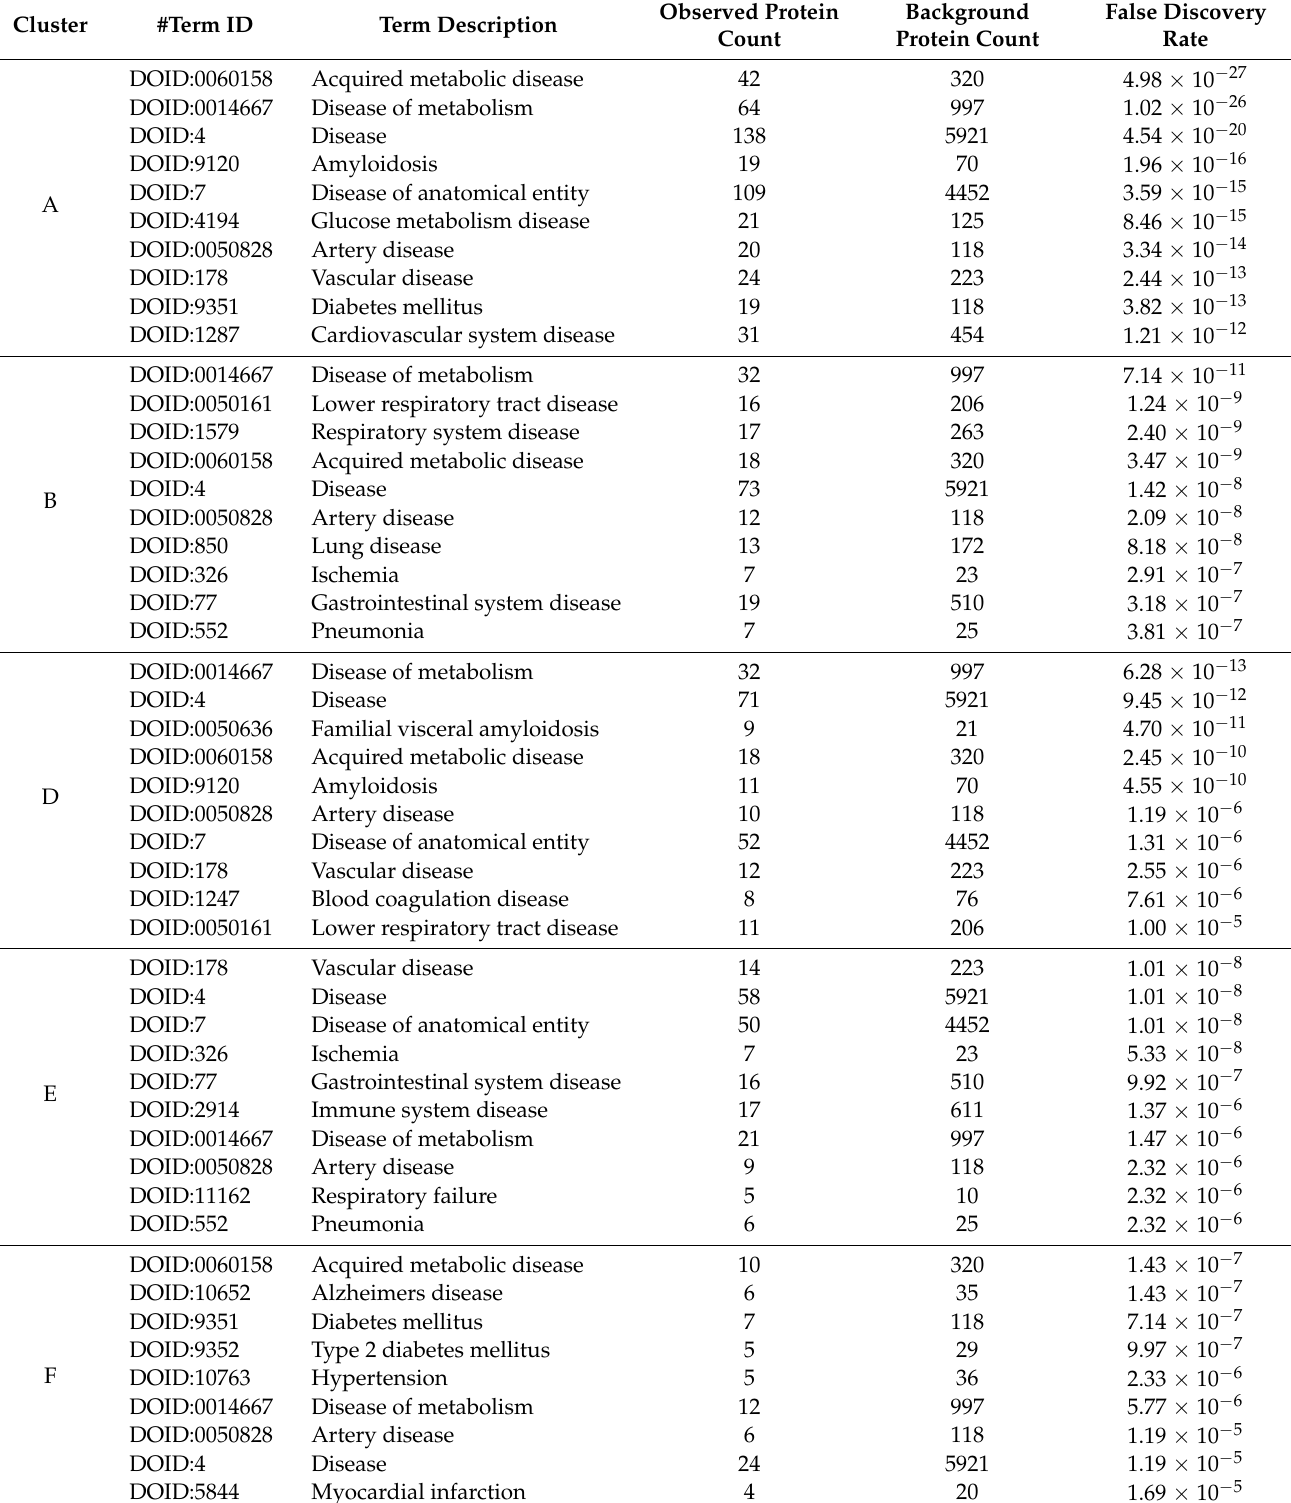
Table 4. Disease Associations of Proteins in Thematic Clusters 1